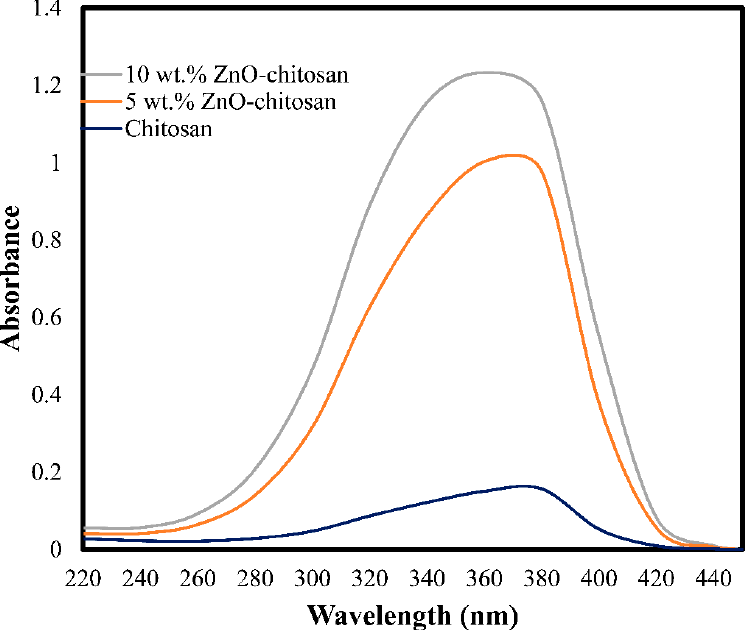
Figure 1. UV-visible absorbance spectra of 5 wt.% ZnO-chitosan and 10 wt.% ZnO-chitosan